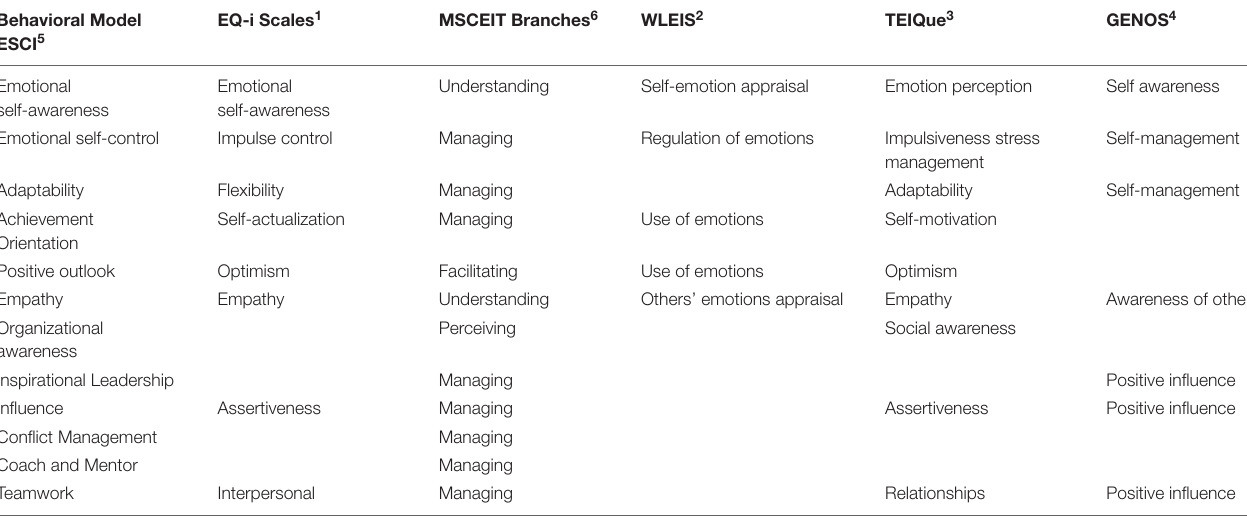
TABLE 1 | Content comparison of behavioral model EI competencies (ESCI) with the scales of other